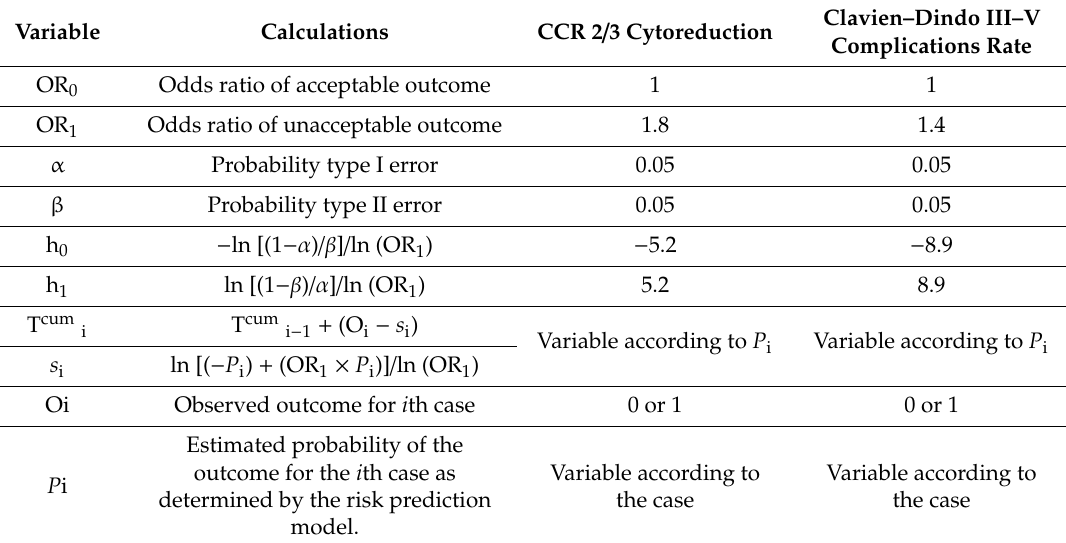
Table 6. Equations and variables to construct a risk-adjusted sequential probability test (RA-SPRT) chart